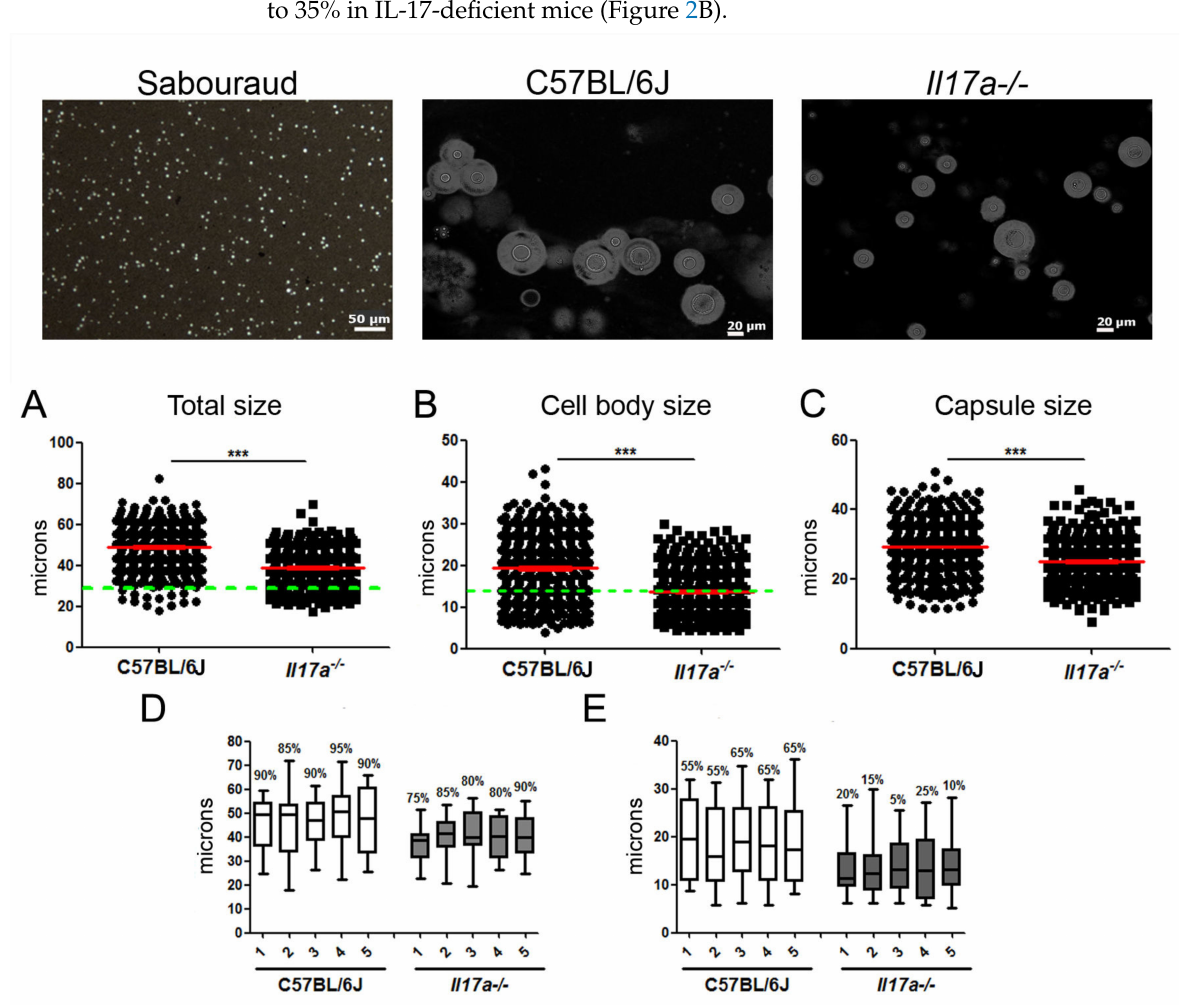
Figure 1. Morphology of C. neoformans in C57BL/6J and Il17a − / − mice (top panels). Cells of C. neoformans H99 (10 6 cells/mouse) were inoculated male C57BL/6J and Il17a − / − mice as indi- cated in M&M. After 9 days of infection, lungs were isolated and homogenized. Size of yeasts was visualized after suspending extracts in India ink. ( A ) Distribution of total cell size, ( B ) cell body size, and ( C ) capsule size of C. neoformans . Red lines represent mean and standard error. Green lines indicate extent to which Titan cells were considered. Box and whisker plot of total cell size distribution. Line inside box represents median, and top and bottom lines represent 75th and 25th percentiles, respectively. Numbers above each distribution indicate percentage of Titan cells found in each animal. ( D ) Total cell size and ( E ) cell body size obtained in 5 mice of each strain. Asterisks indicate significant